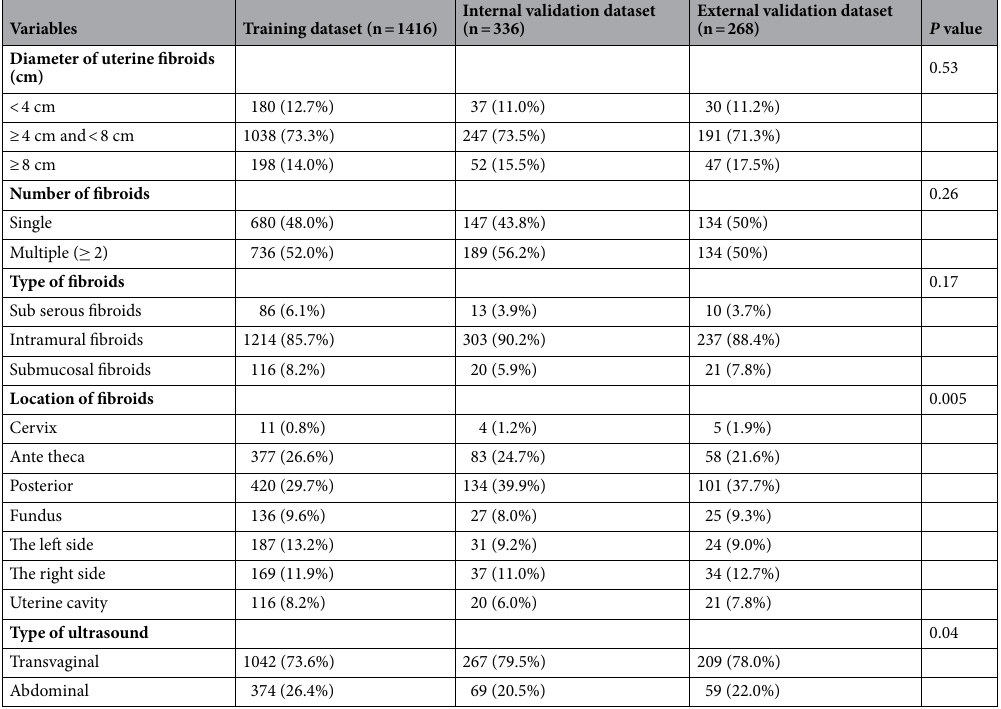
Table 2. Data summaries for the training, internal validation and internal validation test groups. Except where indicated, the data are numbers of ultrasound images with percentages in